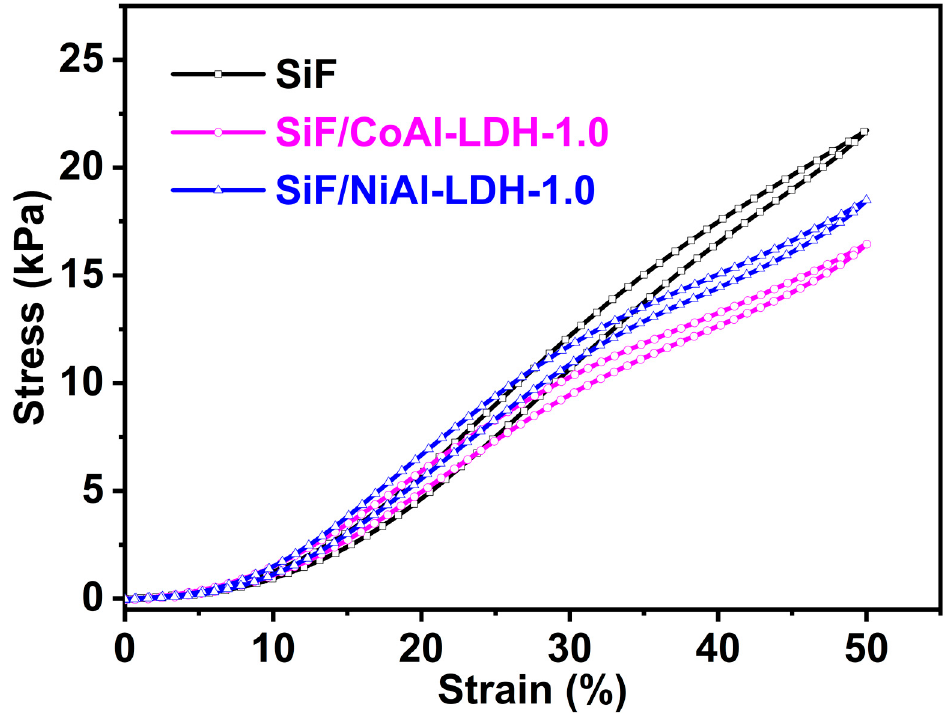
Figure 9. The compressive stress–strain curves of the SiF and SiF/LDH nanocomposites.